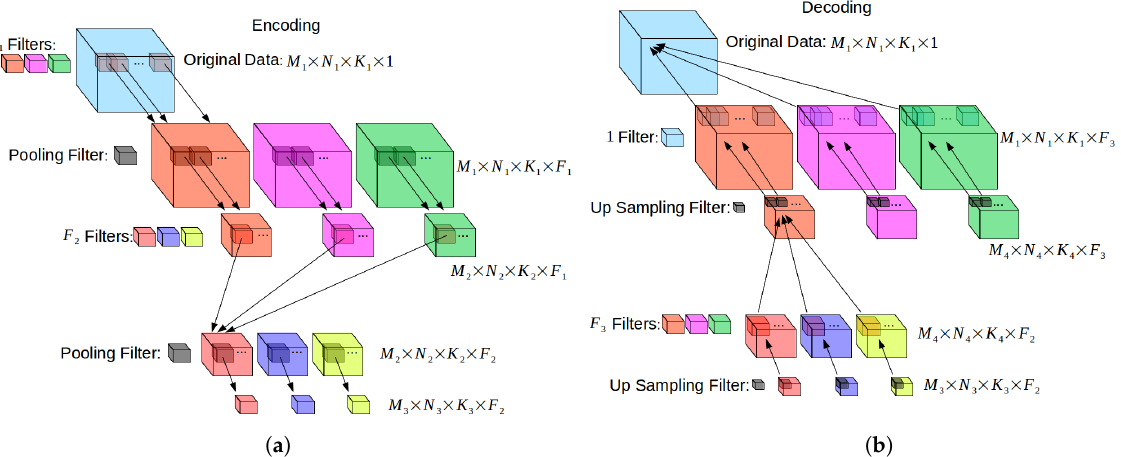
Figure 2. Diagram of convolutional autoencoder. The encoder ( a ) contains successive convolutional and pooling layers which downsize the data. The decoder ( b ) contains successive convolutional and upsampling layers which restore the data to its original